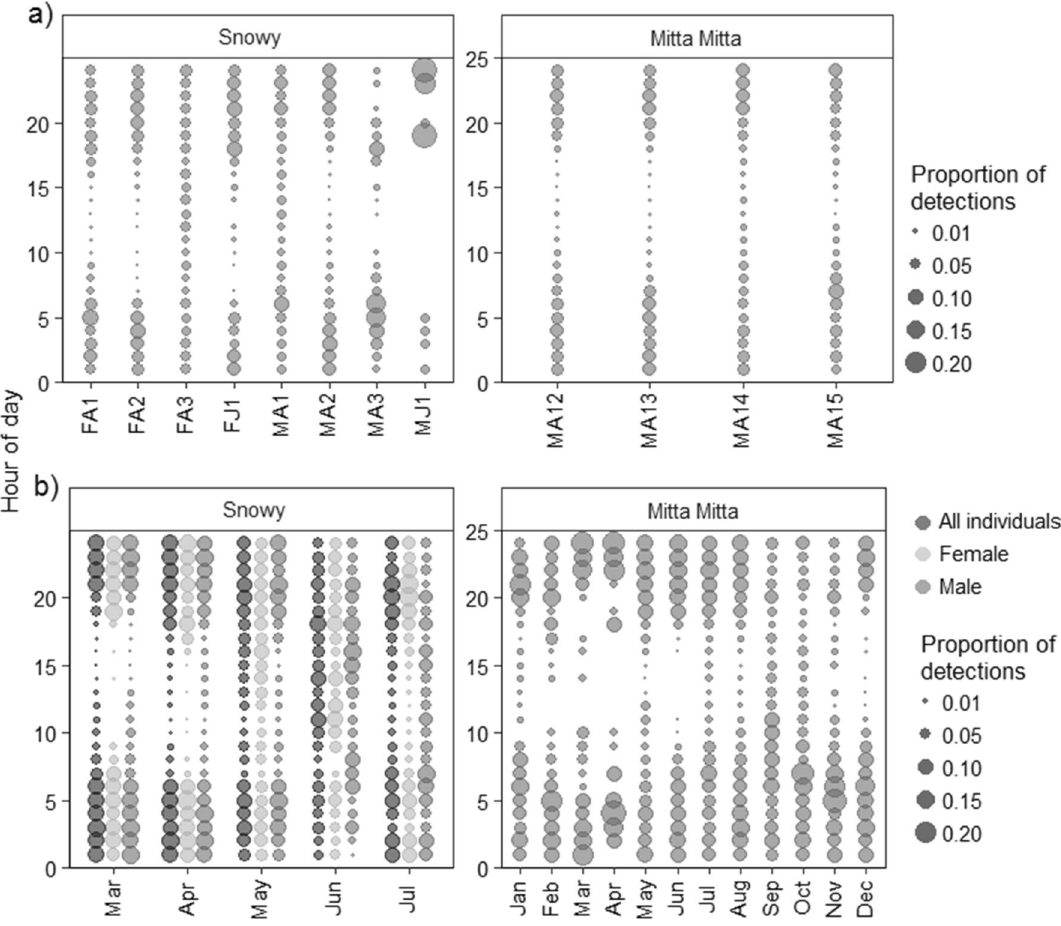
Figure 4. Proportion of hourly detections for platypuses on the Snowy River ad Mitta Mitta River for ( a ) individuals across the entire study period and ( b ) monthly variation between